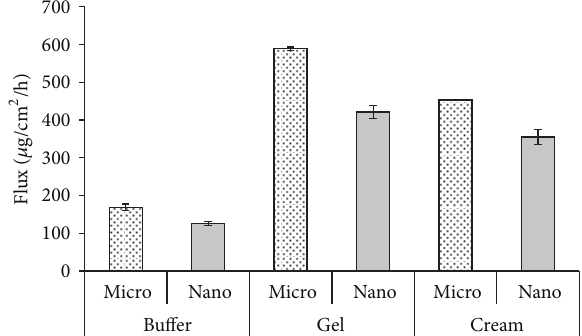
Figure 3: Range of nonsteady permeation flux (mean of five experiments ± SD) of micronized and nanonized alaptide from various